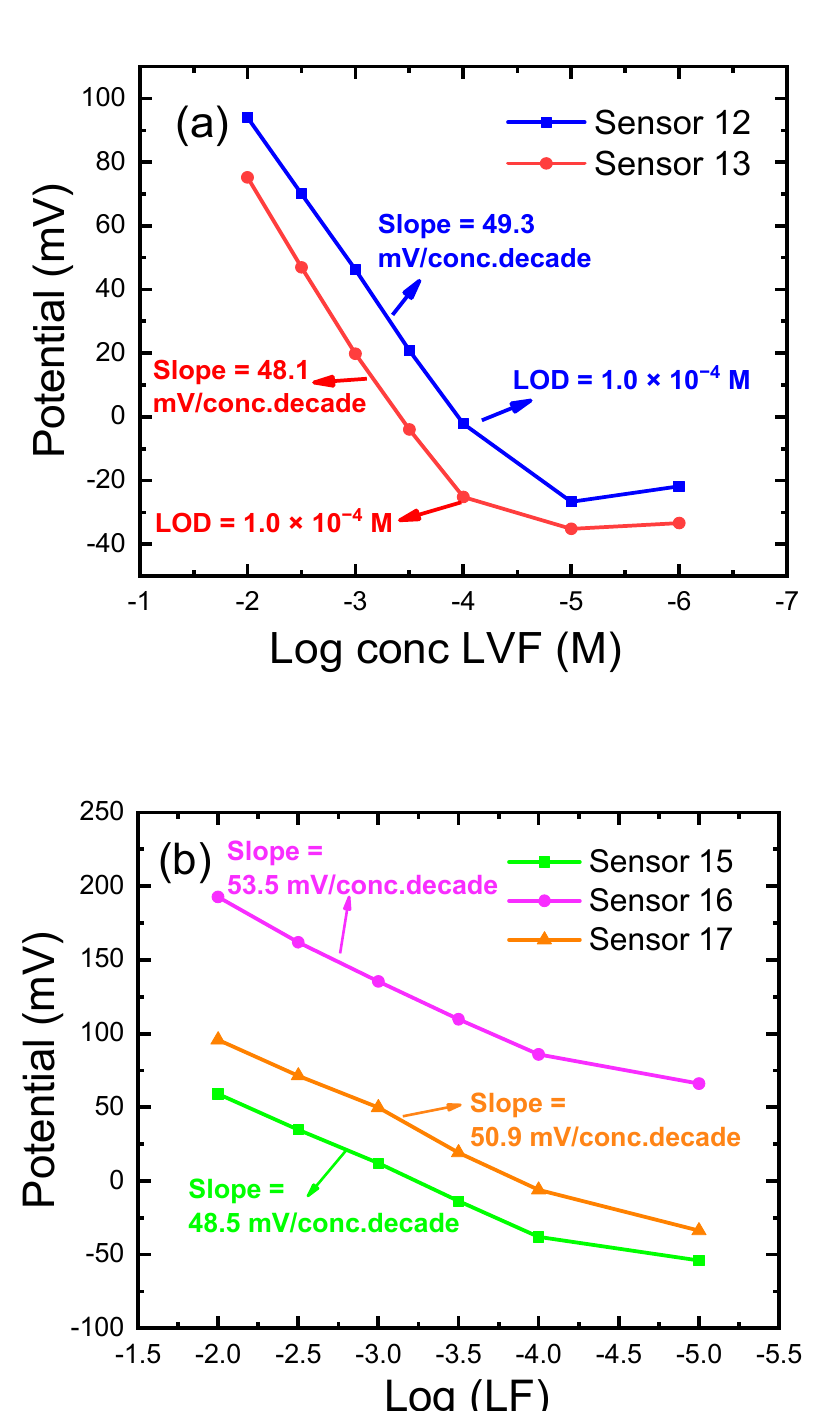
Figure 5. Response characteristics of the prepared electrodes for LF determination: ( a ) calibration curves of the different PVC membrane-coated carbon paste electrodes (C-CPEs); ( b ) Calibration curves of the different PVC/CD plasticized carbon paste electrodes (P-CPEs). The electrode compositions (%, wt / wt ) are given in Table 1. All measurements were at pH 4.1 using acetate buffer at room temperature of 22 ± 2 °C .